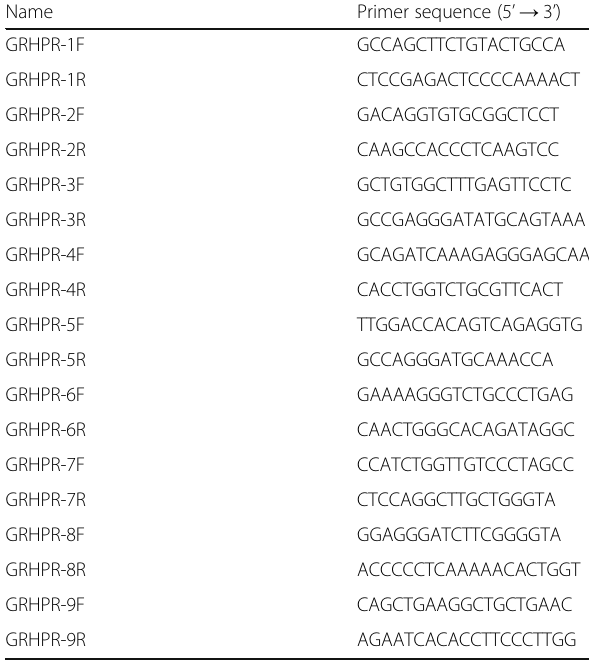
Table 2 Primers used for amplification of genomic GRHPR